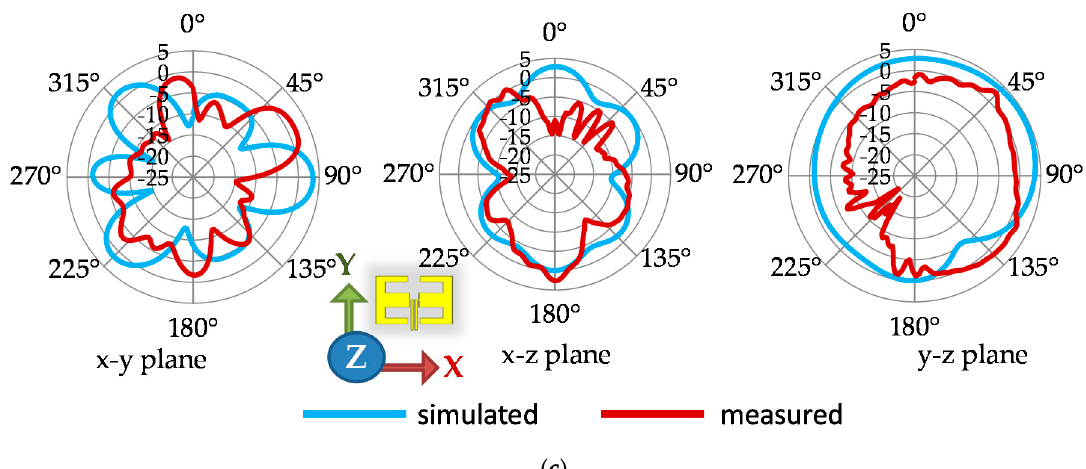
Figure 7. Simulated and measured radiation patterns of the antenna in free space when relaxed at: ( a ) 2.45 GHz, ( b ) 5.25 GHz and ( c ) 5.75 GHz.